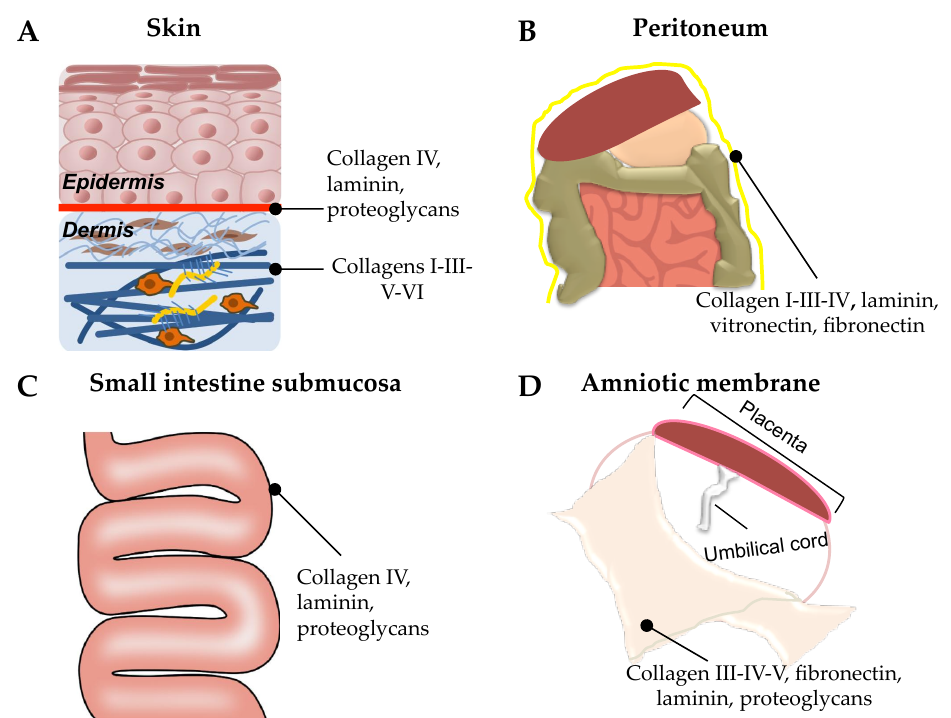
Figure 1. Schematic representation of tissue sources for the preparation of decellularized matrix to support skin repair and regeneration. Basic structure, composition and location of each tissue source are indicated for ( A ) Skin, ( B ) Peritoneum, ( C ) Small intestine submucosa, ( D ) Amniotic